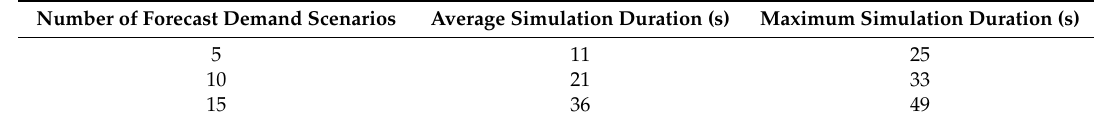
Table 3. The computational e ff ort for